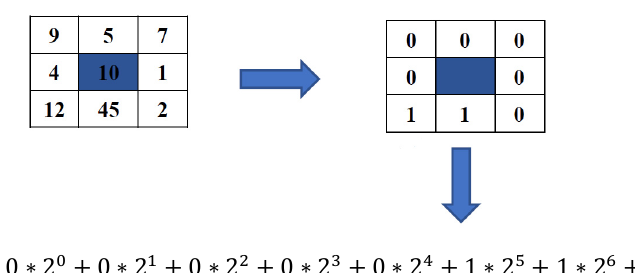
Figure 2. LBP process